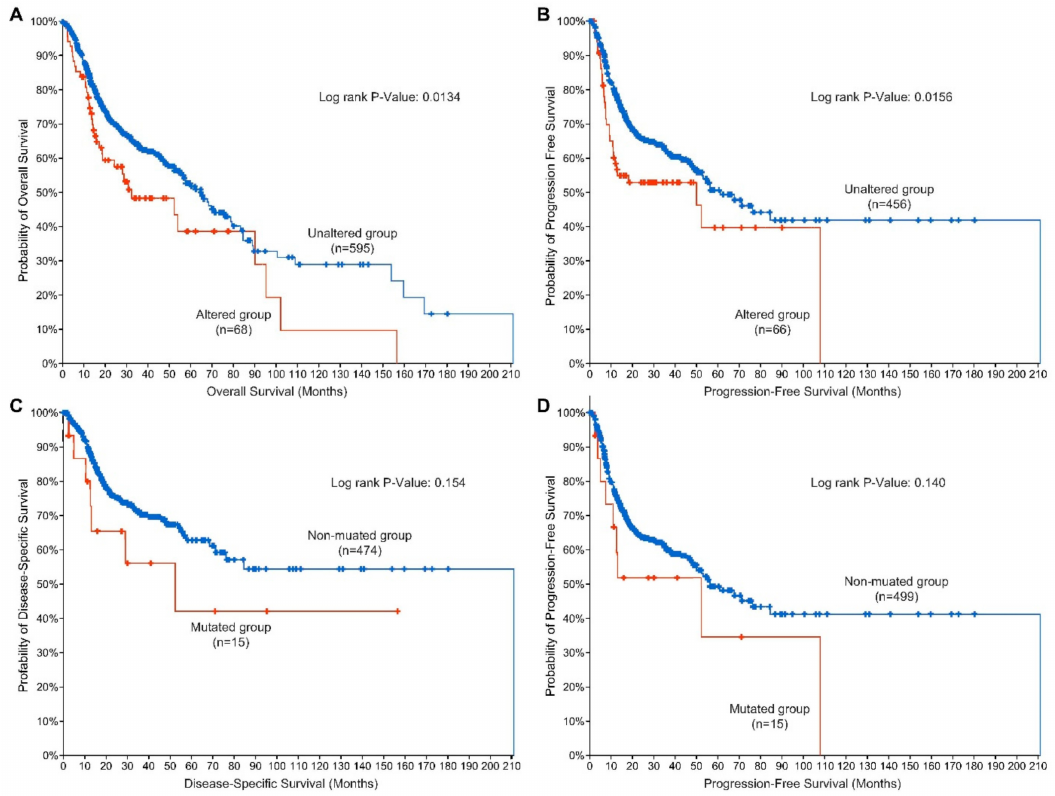
Figure 5. EGFR alterations and survival in H&N cancer patients curated in the cBioPortal for Cancer Genomics. Patients who carry EGFR mutations and/or amplifications demonstrate a significantly briefer overall ( A ) and progression-free survival ( B ) than patients with unaltered EGFR . EGFR mutations are suggestively associated with disease-specific ( C ) and progression-free survival ( D ). EGFR genomic and clinical data were visualized, analyzed, and downloaded from the cBioPortal for Cancer Genomics (https://www.cbioportal.org; accessed on 19 March 2022